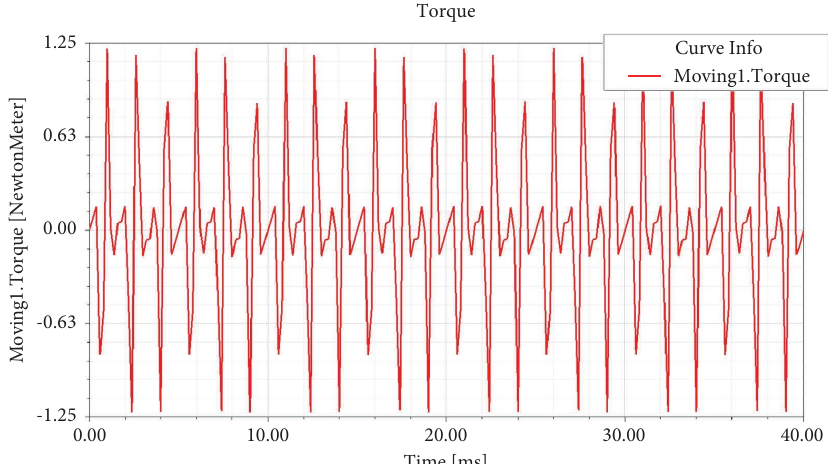
Moving1.TorqueCurve Info